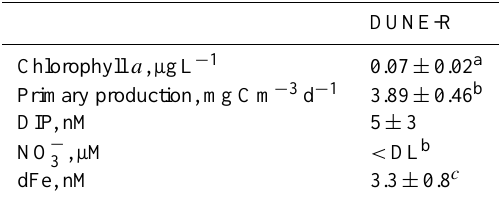
Table 1. Initial biogeochemical conditions of seawater in the DUNE-R experiment (average for C-, D-mesocosms and OUT sam- ples). DIP: dissolved inorganic phosphorus; DL: detection limit ) . Values for chlorophyll a , DIP, NO − (0.03µM for NO − and dFe 3 3 data are average concentrations at surface, 5m and 10m depth. Value for primary production is the mean rate at 5m depth.